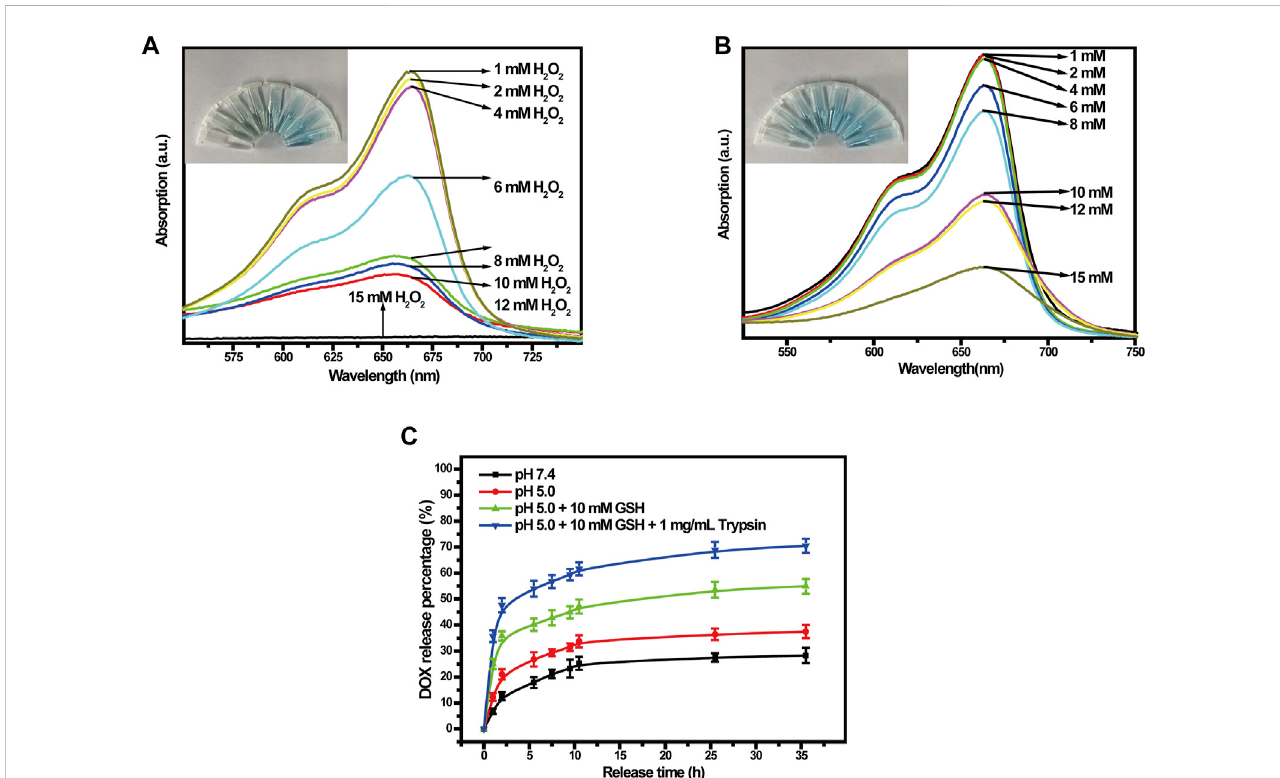
FIGURE 5 (A) UV-VisspectraofdifferentconcentrationsofH 2 O 2 co-incubatedwithCu-MOFsand (B) Cu-MOFs@KeratinGSHsolutions.Cu-MOFsandCu-MOFs@ Keratin can decompose H 2 O 2 to generate OH through a catalytic Fenton-like reaction. To assess the generation of OH, MB with maximum absorption wavelength at 664 nm was used as an indicator, which could be bleached by OH from dark blue to white; (C) Cumulative release curves of DOX-Cu-MOFs@